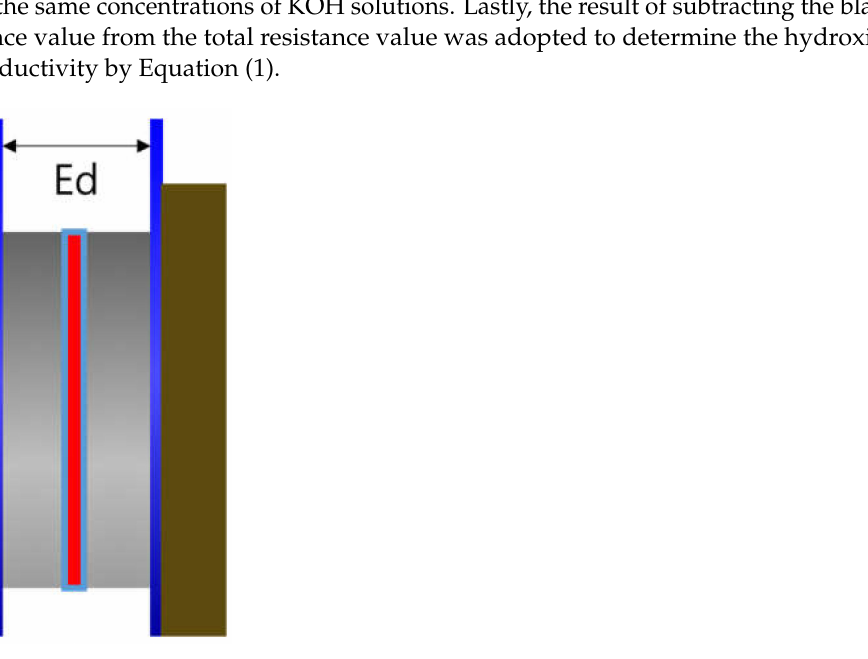
Figure 2. Zero gap cell employing a membrane immersed in a KOH condition (Ed: electrode to electrode distance).